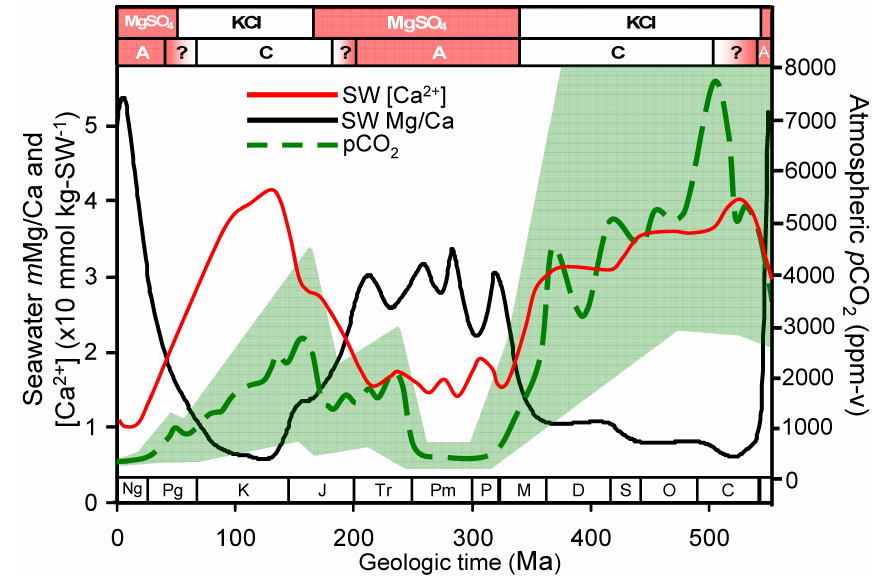
Fig. 29. Models of seawater Mg/Ca (solid black curve; Hardie, 1996; DeMicco et al., 2005), seawater [Ca 2 + ] (solid red curve; Hardie, 1996; DeMicco et al., 2005), and atmospheric p CO 2 (dashed green curve – green shading represents model uncertainty; Berner and Kothavala, 2001) throughout Phanerozoic time. Seawater [Ca 2 + ] and atmospheric p CO 2 have generally varied in synchroneity with each other be- cause they are both thought to have been largely driven by the global rate of ocean crust production. This results in seawater Mg/Ca and atmospheric p CO 2 generally varying inversely with each other throughout Phanerozoic time. Thus, the effect of CO 2 -induced ocean acidifi- cation (i.e., reduced [CO 2 − ]) on biogenic calcification throughout the geologic past may have been mitigated by corresponding elevations in 3 [Ca 2 + ], which would have (1) partially offset the reduction in CaCO 3 saturation state that was associated with the CO 2 -induced reduction in [CO 2 − ] and (2) favored the precipitation of the less soluble low Mg calcite polymorph (because of low seawater Mg/Ca) when seawater 3 CaCO 3 saturation state was low. Because the modern anthropogenic ocean acidification event is not tectonically driven, there should be no commensurate elevation in seawater [Ca 2 + ] to mitigate the effect of the CO 2 -induced reduction in [CO 2 − ] on the calcium carbonate 3 saturation state of